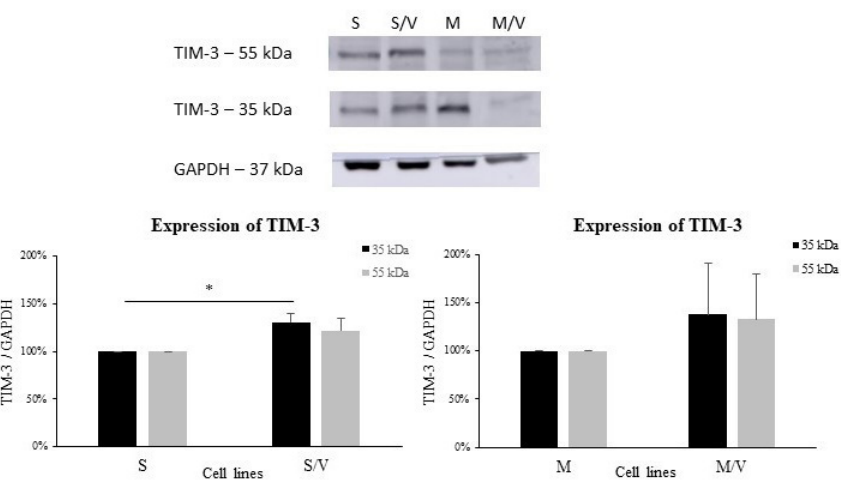
Figure 3. Protein expression of TIM-3. Upper panel—representative Western blot. Lower panel— densitometric analysis of protein bands (35 and 55 kDa) in SKM-1 and SKM-1/VCR ( left ) and MOLM-13 and MOLM-13/VCR ( right ). Upregulation in the resistant cell line was statistically significant (* p ≤ 0.05) only for the 35 kDa band in SKM-1/VCR cells in comparison to the parental cell line. Data represent the mean ± SEM of 3 independent experiments. S—SKM-1; S/V—SKM-1/VCR; M—MOLM-13; M/V—MOLM-13/VCR.